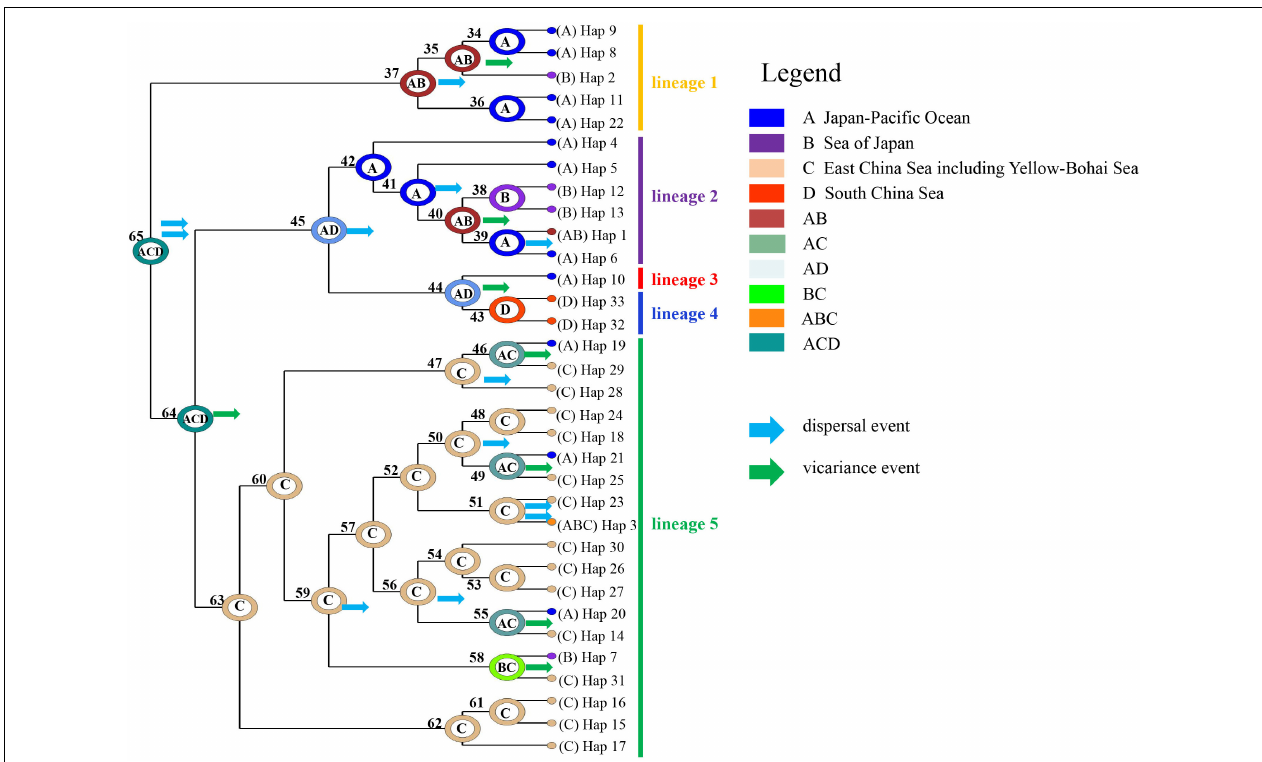
FIGURE 4 | Ancestral phylogeographic reconstruction of Agarophyton vermiculophyllum based on mitochondrial DNA (mtDNA) cox 1. Colored circles on each node indicate the likelihood of occurrence of each ancestral haplotype at an inferred ancestral biogeographic region. Blue and green arrows indicate potential dispersal and vicariance events,